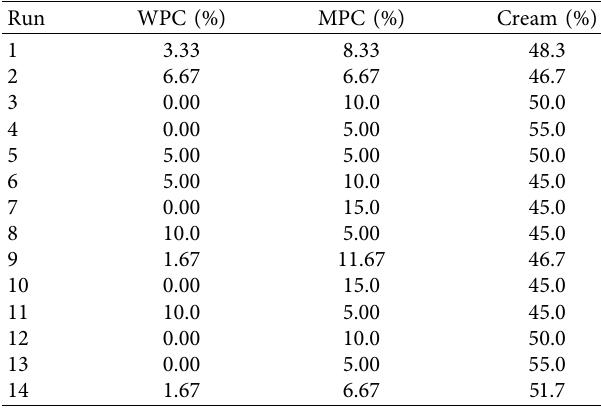
Table 1: Experimental design variables ∗ and levels ∗∗ .